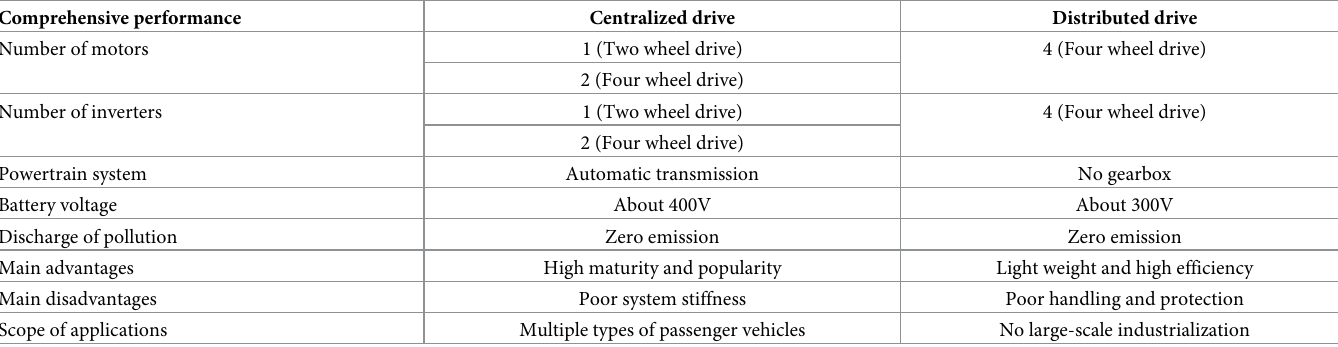
Table 1. Structure and characteristics of